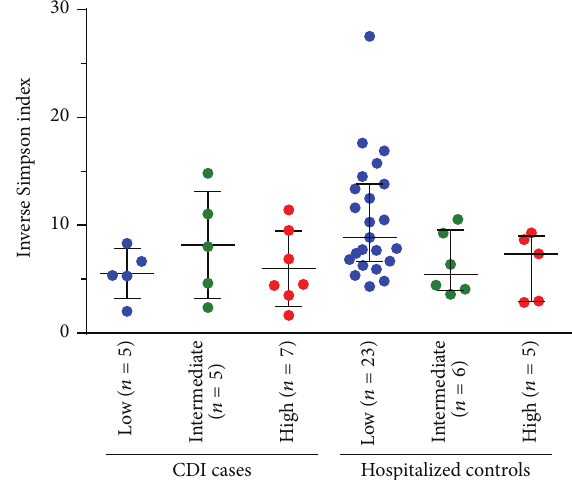
Figure 2: Intestinal microbiota diversity in hospitalized cases and controls as a function of host DNA abundance. Each patient group was divided into three subgroups with low ( < 30%, shown in blue), intermediate (30–70%, shown in green), and high ( > 70%, shown in red) proportions of human reads. One sample from the CDI group and two samples from hospitalized controls were excluded because they contained less than 15 reads with a 16S rDNA motif. Horizontal lines represent the median and interquartile